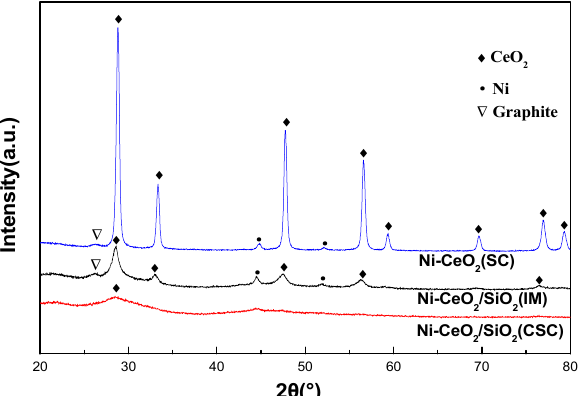
Figure 8. XRD patterns of the used Ni-CeO 2 (SC), Ni-CeO 2 /SiO 2 (IM), and Ni-CeO 2 /SiO 2 (CSC) catalysts.